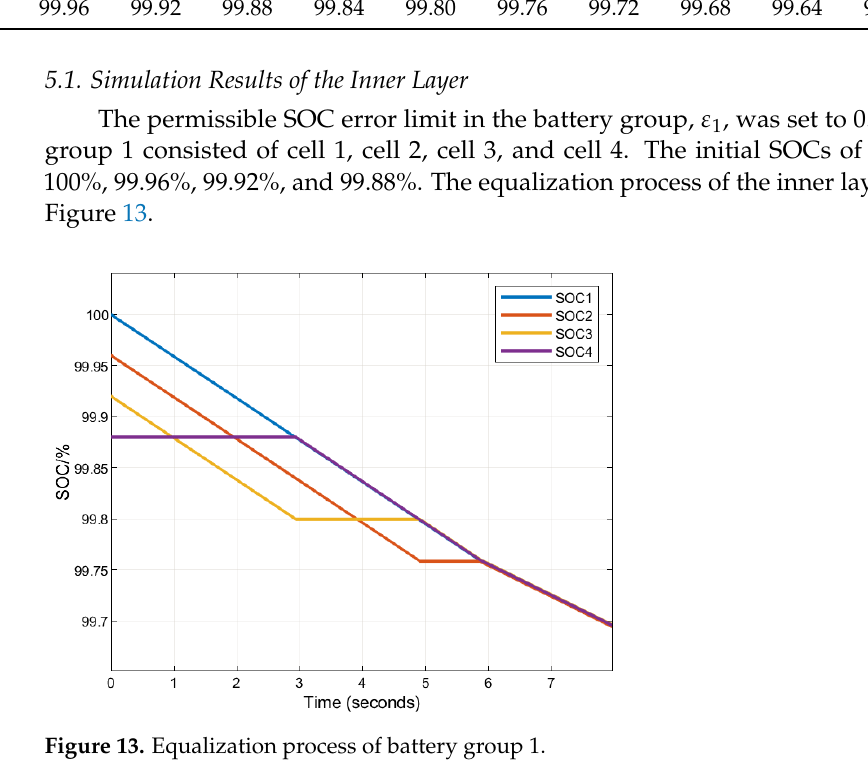
Figure 12. Schematic diagram of proposed method.